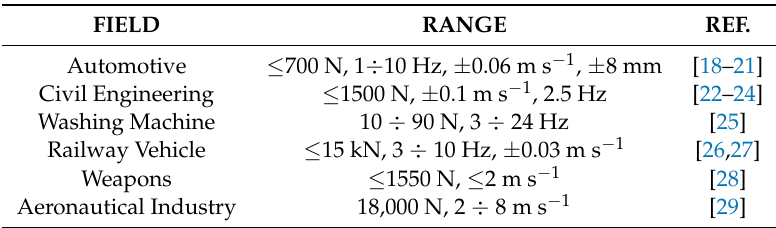
Table 1. Examples of application of magnetorheological (MR) dampers.